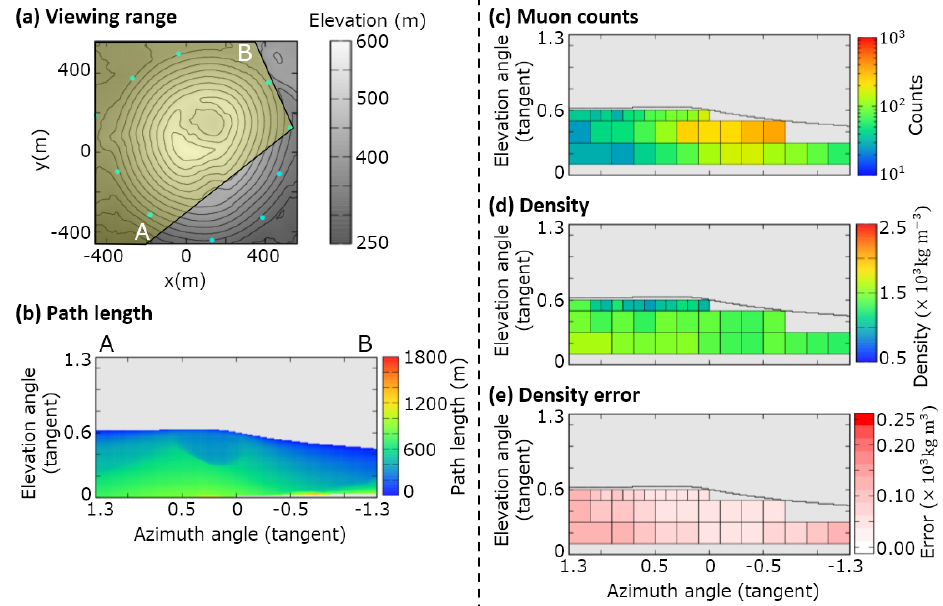
Figure B8. Observation site E. (a) Map, topography, and viewing range; (b) path length of the volcanic cone; (c) muon counts N obs (d) density ρ i . The maximum value of the color bar indicates a density of > 2 . 5 × 10 3 kgm − 3 and the minimum value is < 0 . 5 × 10 3 kg − 3 . (cid:16) (cid:17) − ρ low ρ up / 2. The maximum value of the color bar indicates a density error of > 0 . 25 × 10 3 kgm − 3 . (e) Density error (cid:49)ρ = i i